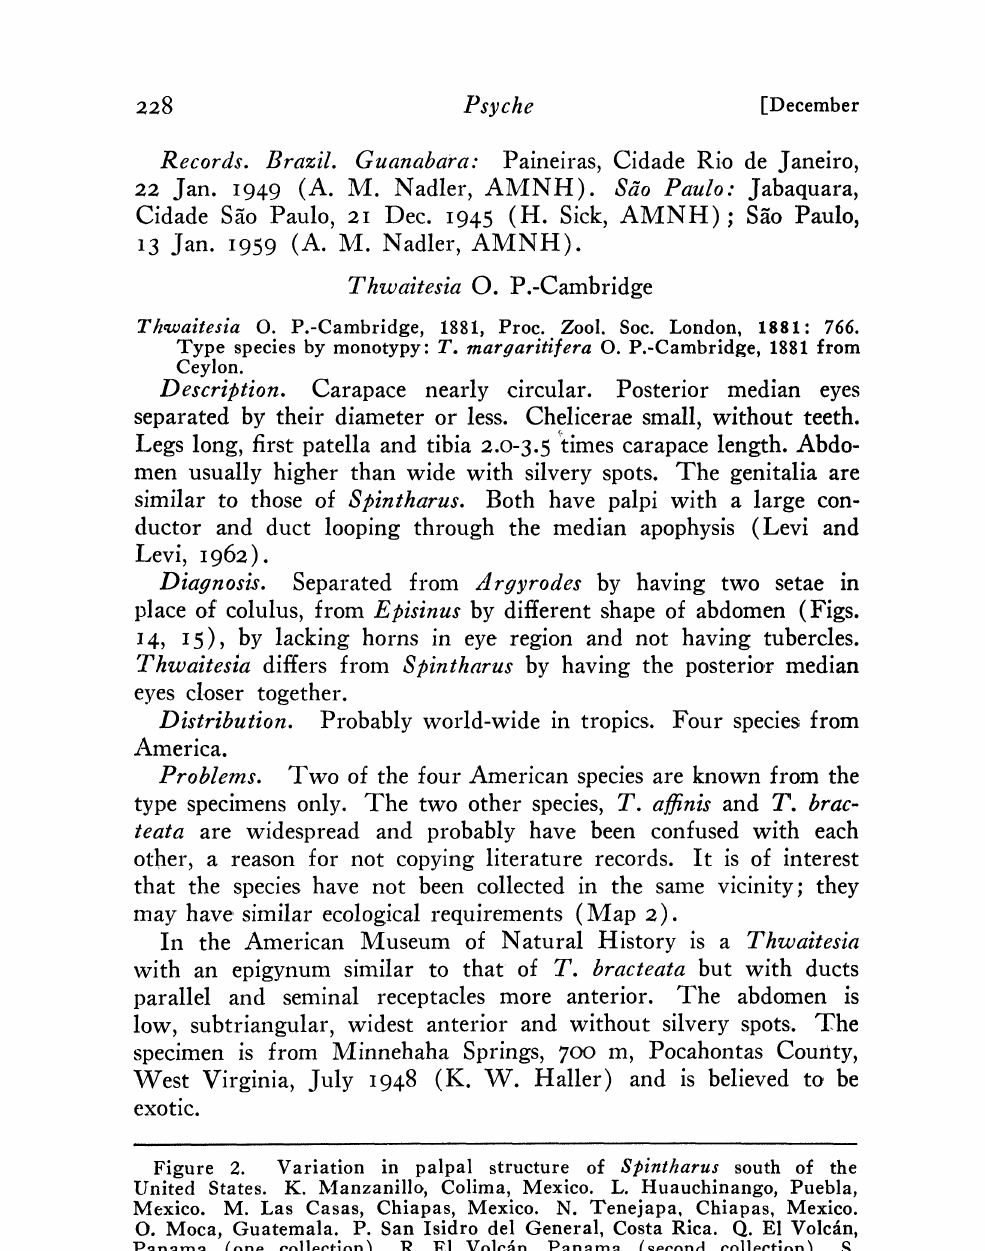
Figure 2. Variation in palpal structure of Spintharus south of the United States. K. Manzanillo, Colima, Mexico. L. Huauchinango, Puebla, Mexico. M. Las Casas, Chiapas, Mexico. N. Tenejapa, Chiapas, Mexico. O. Moca, Guatemala. P. San Isidro del General, Costa Rica. Q. E1 Volcin, Panama (one collection). R. E1 Volcin, Panama (second collection). S. Pico Turquino, Oriente, Cuba. T. Portland, Jamaica. 15. Loma Rucilla, Dominican Republic. V. Rio de Janeiro, Brazil. W. Utcuyacu, Junln, Peru. (K-U, W are S. Ita,idus; V is S.